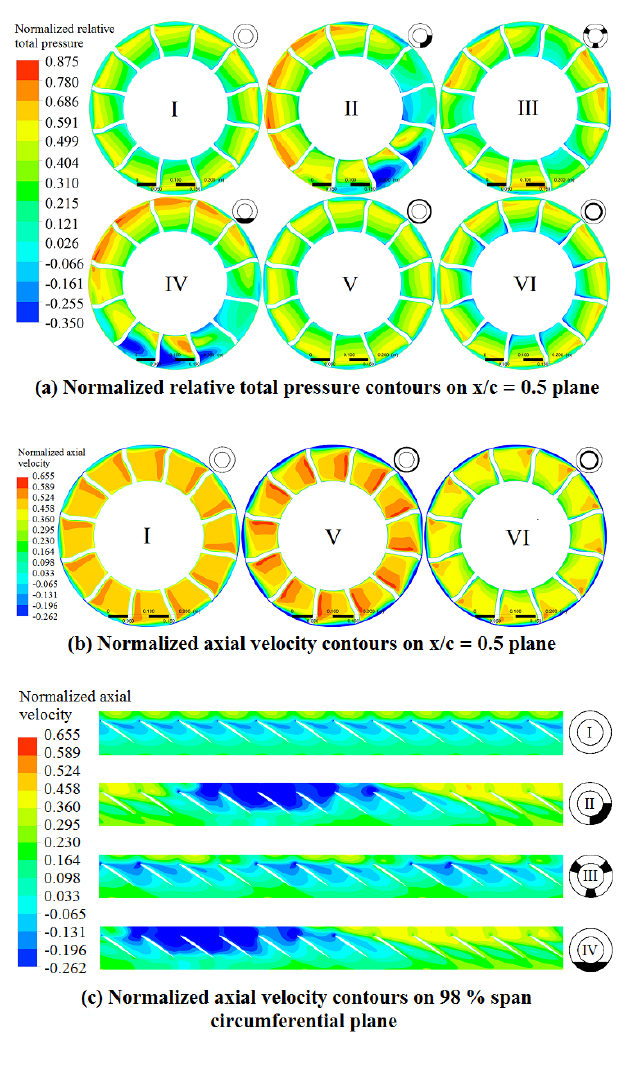
Figure 12. Flow fields for various distortion cases at near stall con- dition.